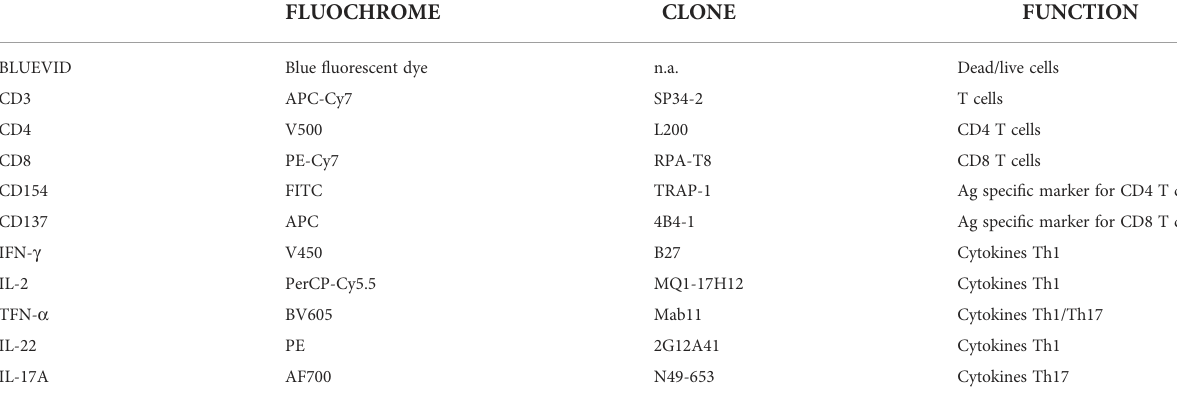
TABLE 1 Antibodies used for staining of immune cell markers and intracellular